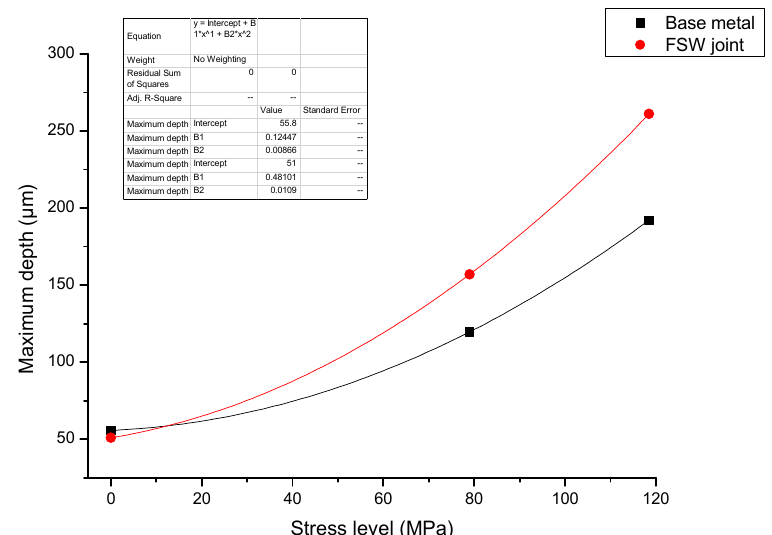
Figure 18. Variation of the average corrosion depth ( μ m) with level of applied stress (MPa) for the two chosen specimens of aluminum alloy 2219. Duration of exposure to environment is 48 h.